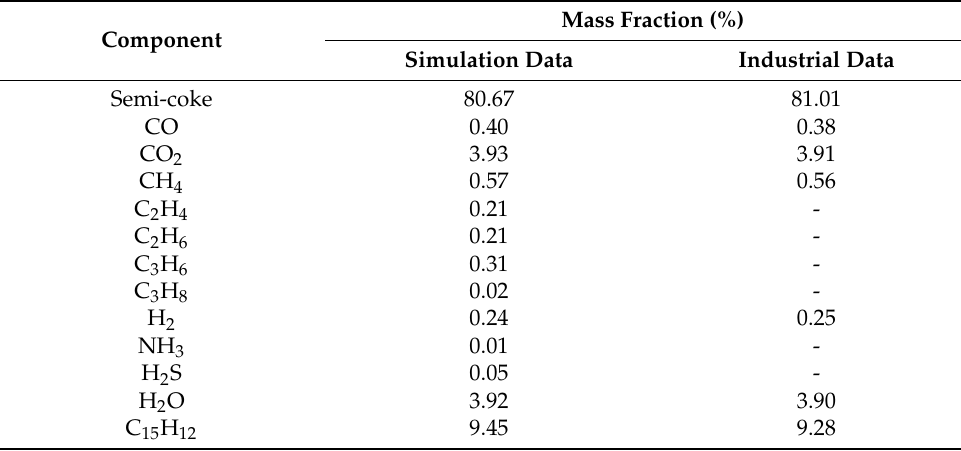
Table 4. Comparison between simulation and industrial data.